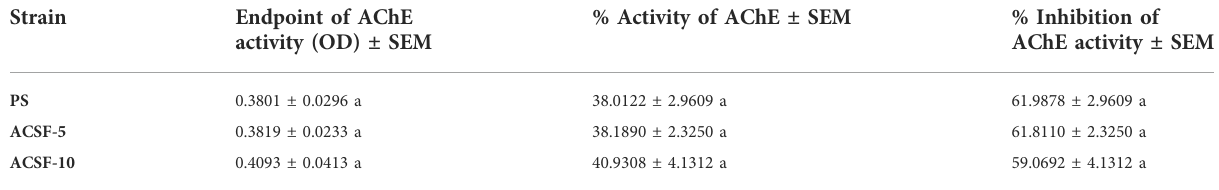
TABLE 4 Mean percent activity and percent inhibition of the AChE activity in parent and acetamiprid-selected larvae of Aedes